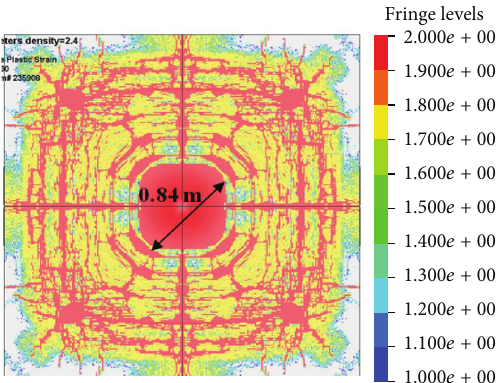
Figure 10: Damaged pattern of normal concrete slab using MAT 72R3 model [16].